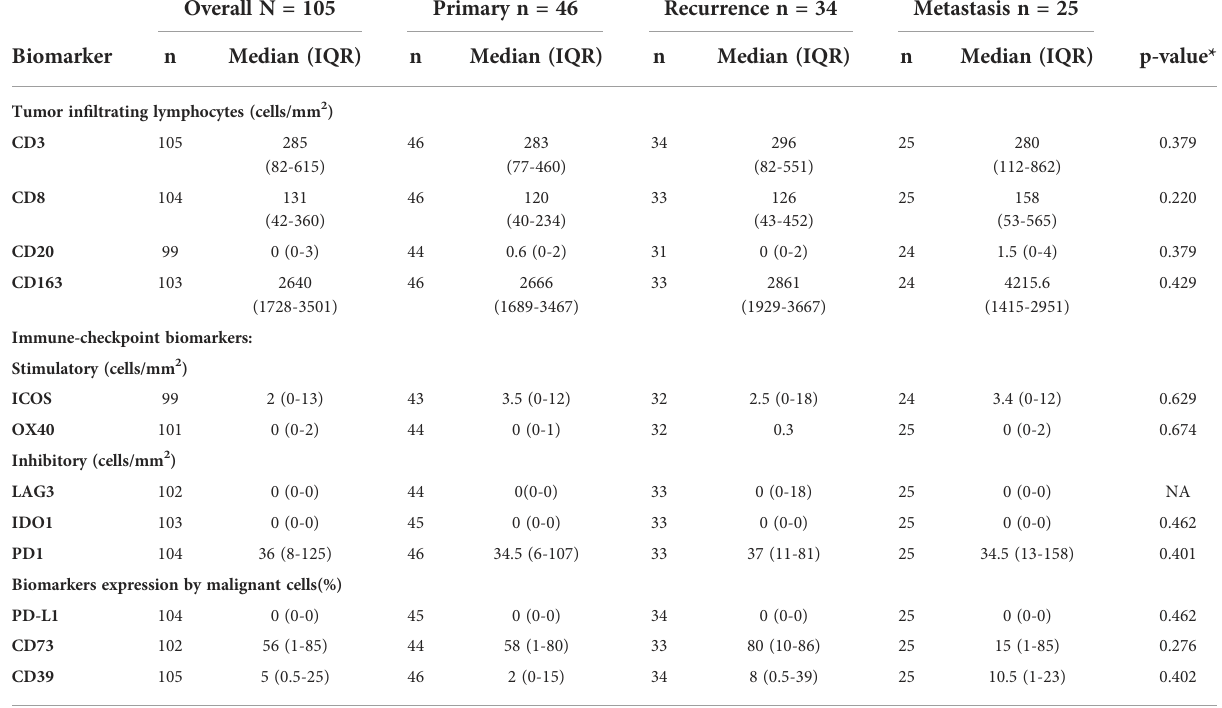
TABLE 2 TILs and immune checkpoint biomarker expression in